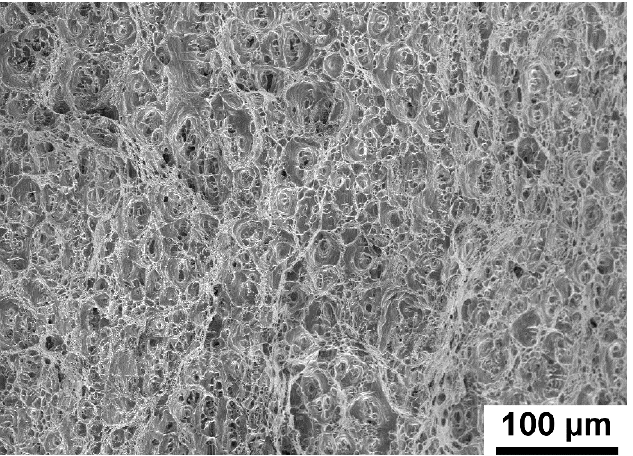
Figure 9. Secondary electron image showing the fracture surface in the HAZ of the AA6061 alloy.